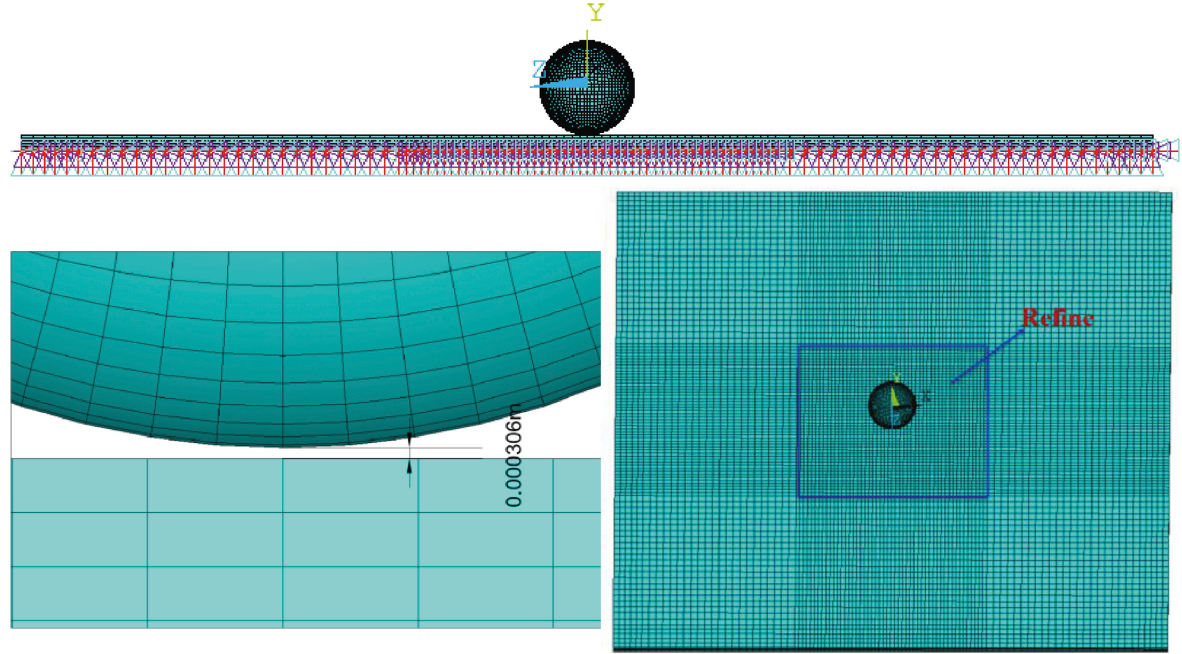
Figure 8: Simulation contact model of the elastic sphere impacting the elastic half